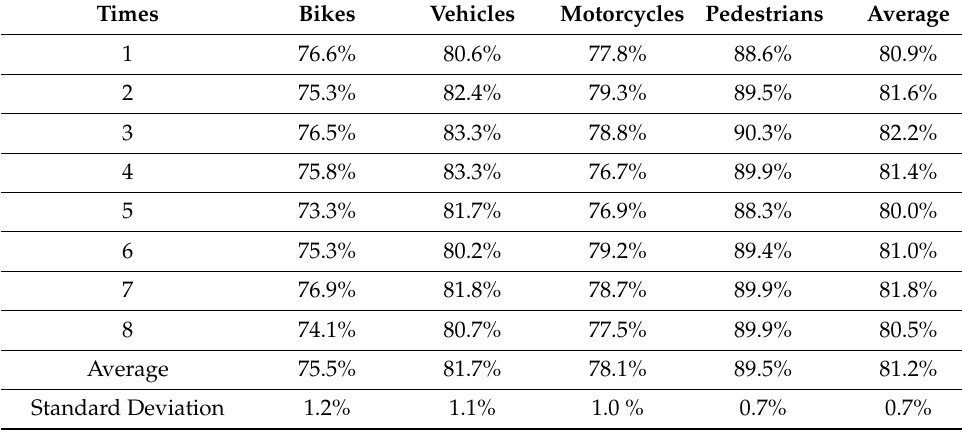
Table 3. VOC2005 results (EER).